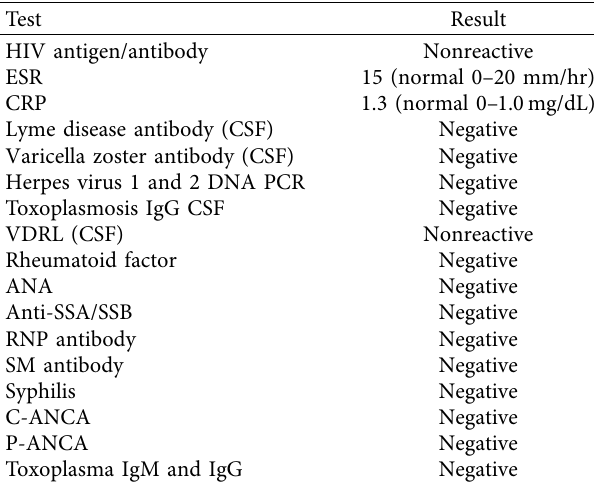
Figure 1: MRI brain. Innumerable foci of parenchymal hemorrhage throughout the bilateral cerebral hemispheres as well as left frontal subarachnoid hemorrhage, with mild edema and minimal local mass effect at these sites. Images (a), (c), and (e) are from a previous MRI brain (12/2020) and images (b), (d), and (f) are from the current MRI (02/2021). Table 1: Vasculitis workup.